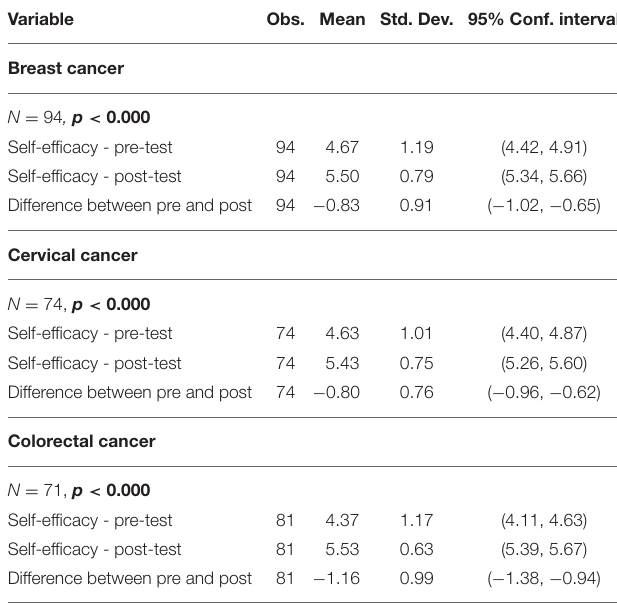
TABLE 3 | Paired T -test results for Promotores’ pre- and post- training self-efficacy scores.